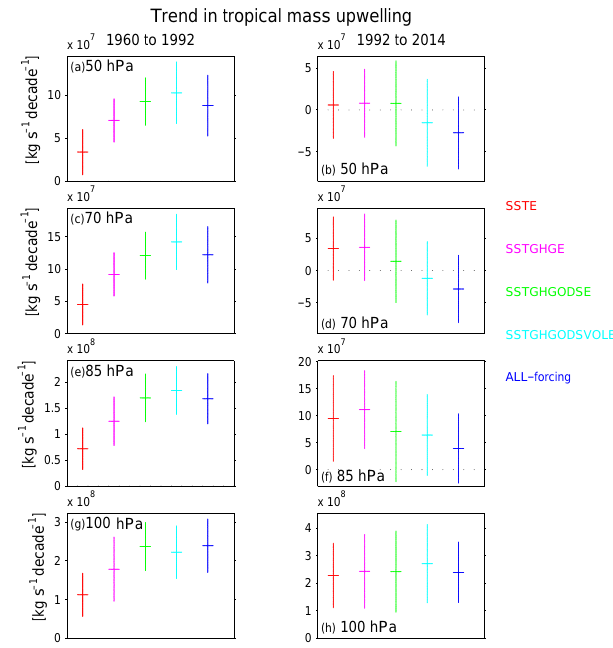
Figure 10. As in Fig. 7 but for tropical mean upwelling at a variety of pressure